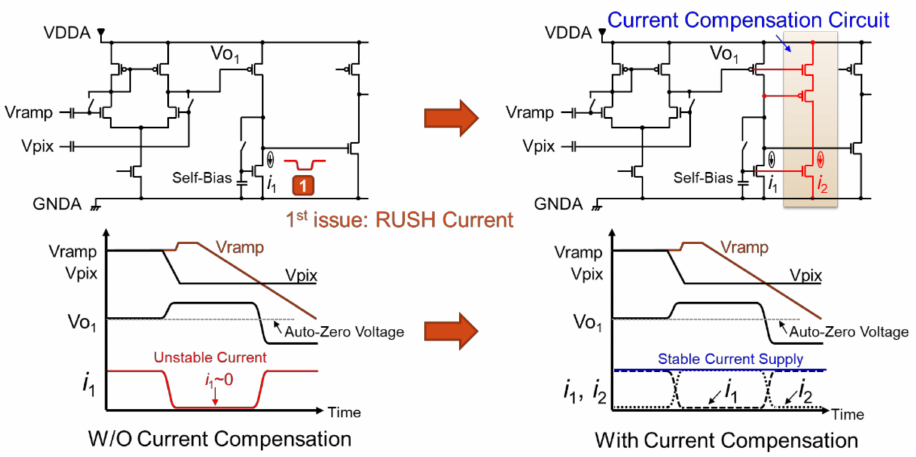
Figure 3. RUSH current compensation.